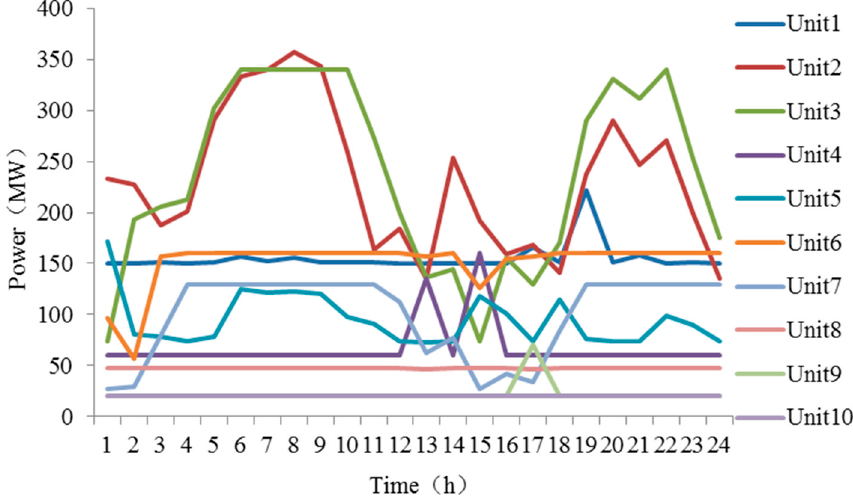
Energies 2018 , 11 , x FOR PEER REVIEW Figure 17. Power output curves of thermal generators in Case 3. Figure 17. Power output curves of thermal generators in Case 3.